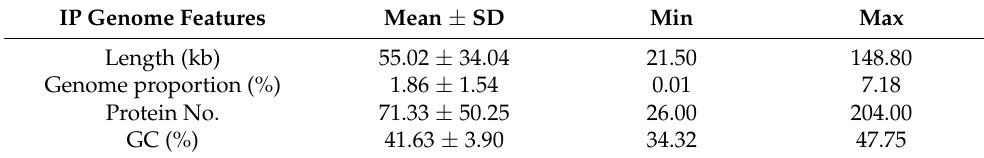
Table 1. Genomic features of 171 intact prophages in B. subtilis predicted by PHASTER. IP Genome